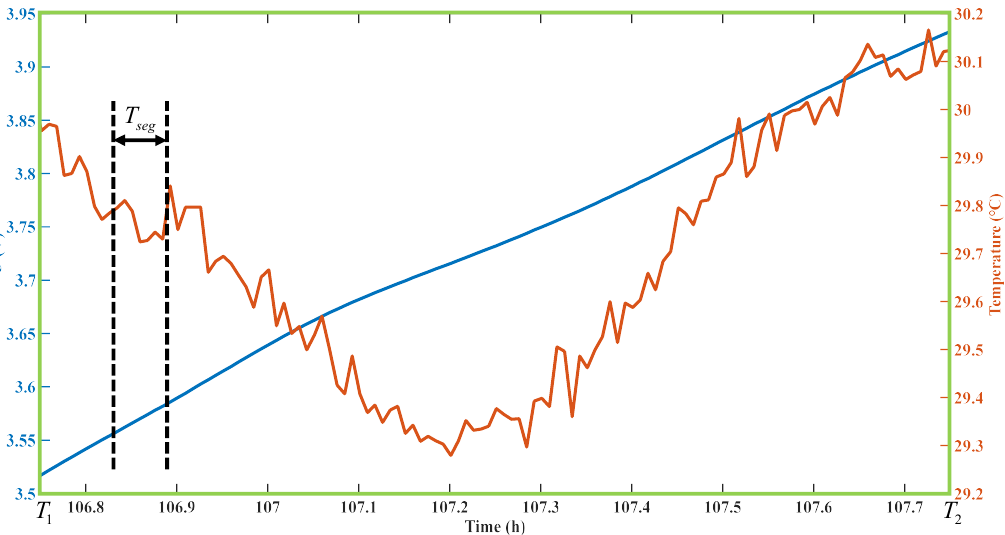
Figure 3. Voltage and temperature data of the corresponding time period [ T 1 , T 2 ] after selecting the starting voltage V 1 and ending voltage V 2